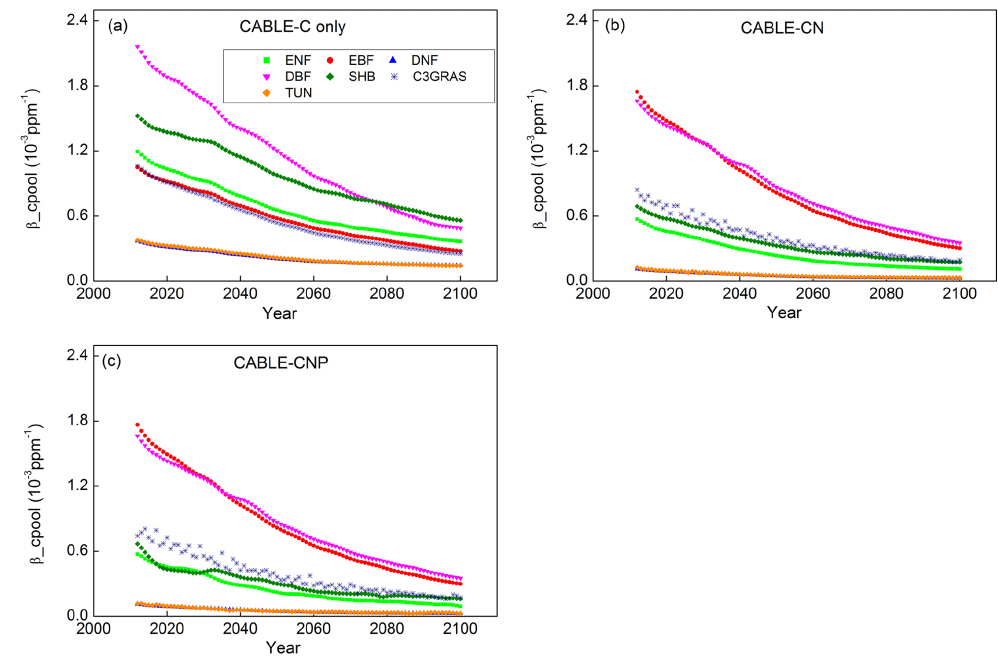
Figure 1. Temporal trends of β cpool from 2011 to 2100 for C 3 PFTs from CABLE-C-only (a) , CABLE-CN (b) , and CABLE-CNP (c) sim- ulations. β cpool values for different C 3 PFTs all decline with time from 2011 to 2100 under the RCP 8.5 scenario, but the magnitudes of β cpool differ across them in all simulations. In C–N and C–N–P simulations, magnitudes of β cpool are reduced compared with those in C-only simulation for all C 3 PFTs except evergreen broadleaf forest. ENF, evergreen needleleaf forest (light green squares); EBF, evergreen broadleaf forest (red circles); DNF, deciduous needleleaf forest (dark blue triangles); DBF, deciduous broadleaf forest (pink triangles); SHB, shrub (dark green diamonds); C3GRAS, C 3 grass (dark blue stars); TUN, tundra (orange diamonds).